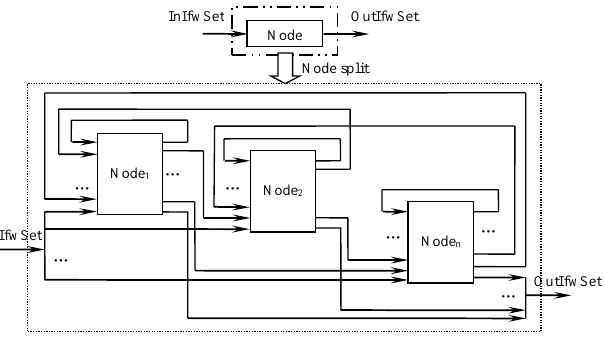
Figure 10. The information flow in node splitting.